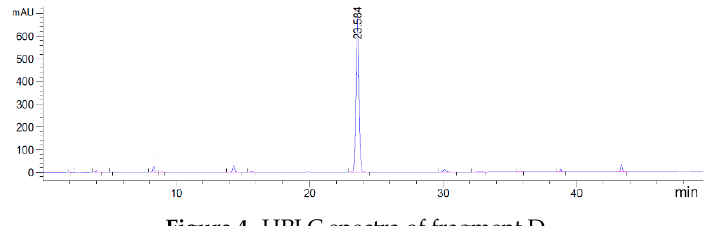
Figure 4. HPLC spectra of fragment D.